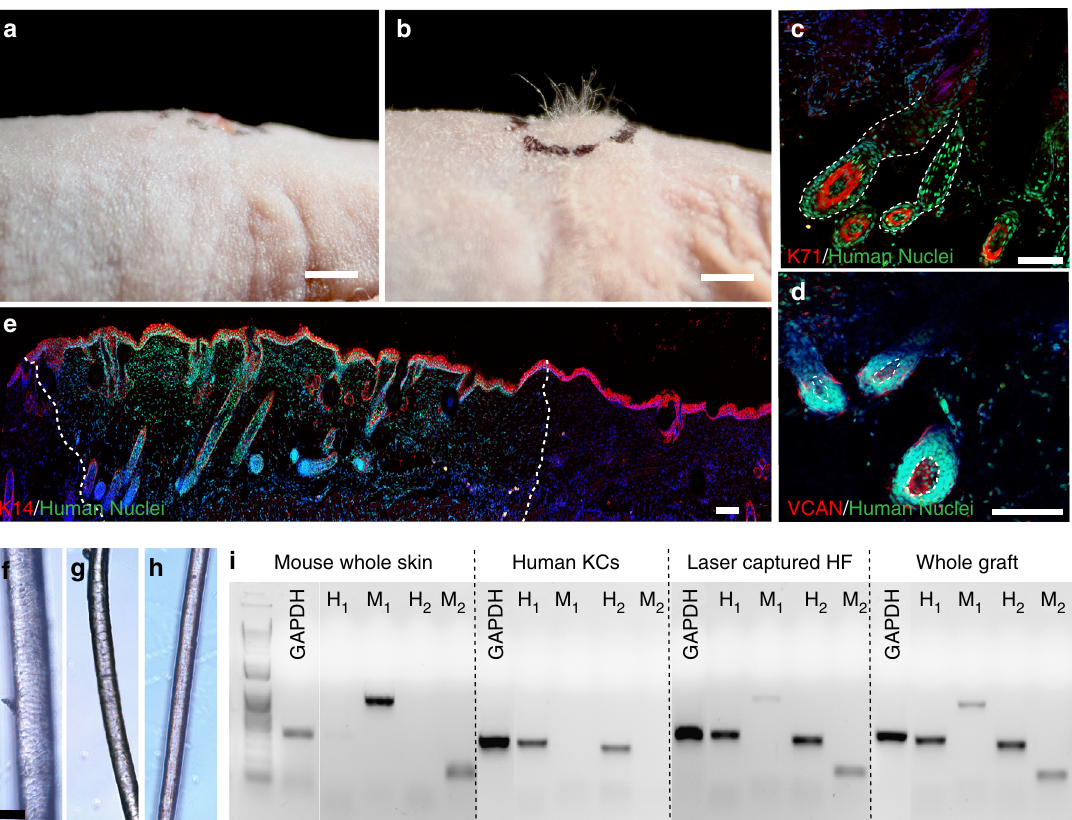
Fig. 5 Induction of human hair growth in immune-de fi cient nude mice. a , b Engraftment of high follicle-density HSCs onto immune-de fi cient nude mice led to hair growth in the grafts after 4 – 6 weeks ( b ), which was not observed in the HSCs prepared with FB aggregates as a control ( a ) ( n = 10; fi ve biological and two technical replicates per each condition). c , d Human-speci fi c nuclear staining (green) indicated that the de novo hair follicles marked with K71 ( c ) (HF boundaries circled in dashed line) and DPCs marked with VCAN ( d ) are comprised of human cells (DPs circled in dashed line). e Low magni fi cation image of the explanted grafts revealed the boundaries (dashed line) between the mouse and human tissues as marked by the human nuclear staining. Bright- fi eld microscopy of unpigmented terminal human hair ( f ), engineered human hair in the grafts ( g ), and unpigmented human vellus hair ( h ) showed morphological similarities between human hair and engineered hair. i PCR was performed with two sets of primers speci fi c to human and mouse cells using the RNA of the laser captured hair follicles from the grafts in comparison to whole grafts, mouse skin, and cultured human KCs. Scale bars for ( a , b ), ( c − e ) and ( f − h ) are 2 mm, 200 µ m, and 50 µ m